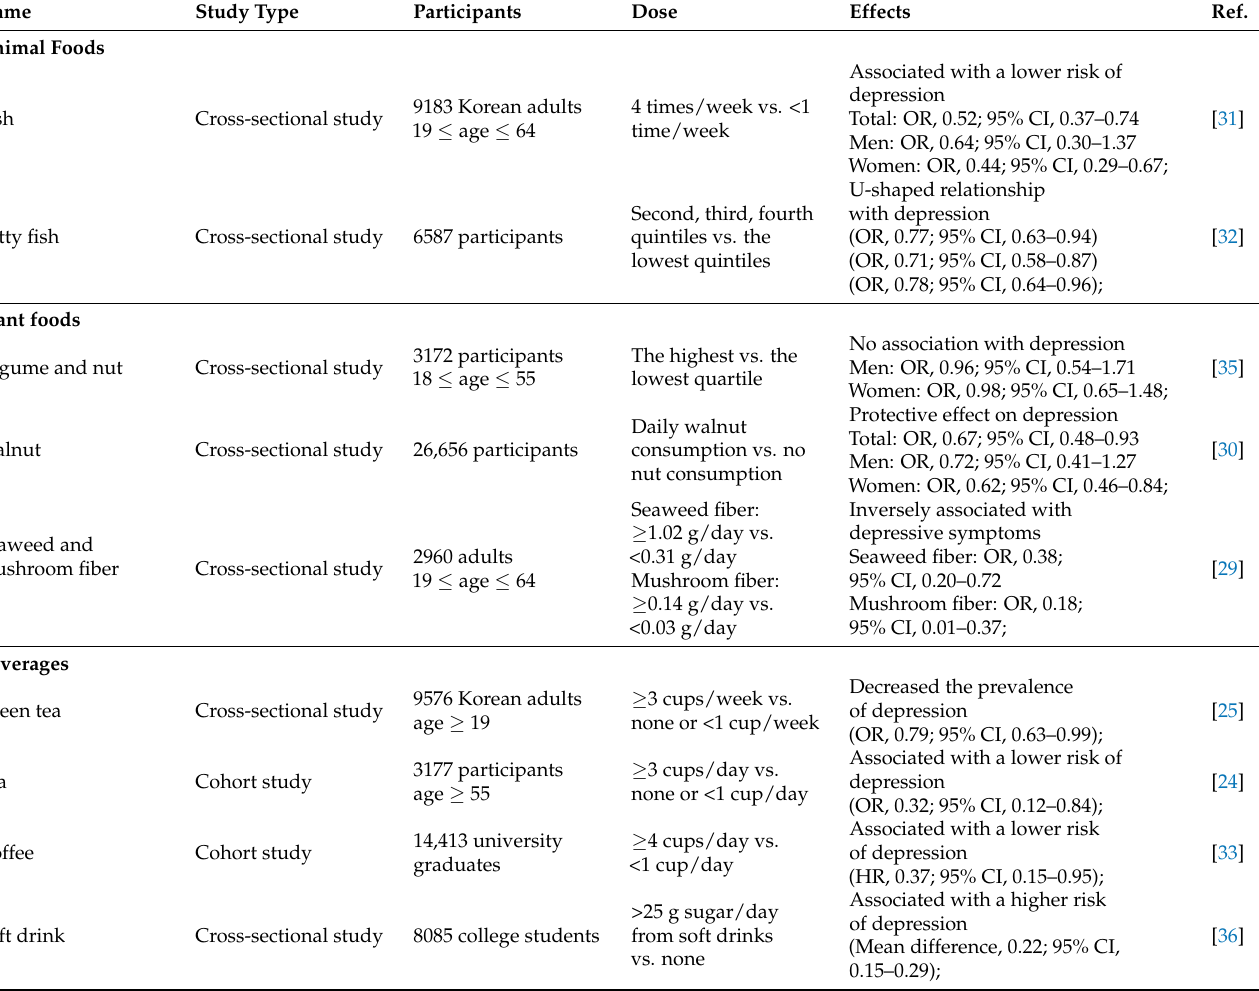
Table 1. Effects of dietary natural products and nutrients on depression from epidemiological